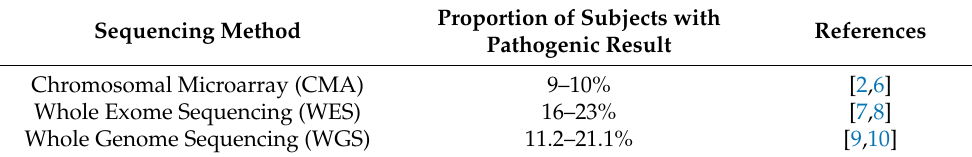
Table 1. Estimated Pathogenic Yield of Genetic Testing by Sequencing